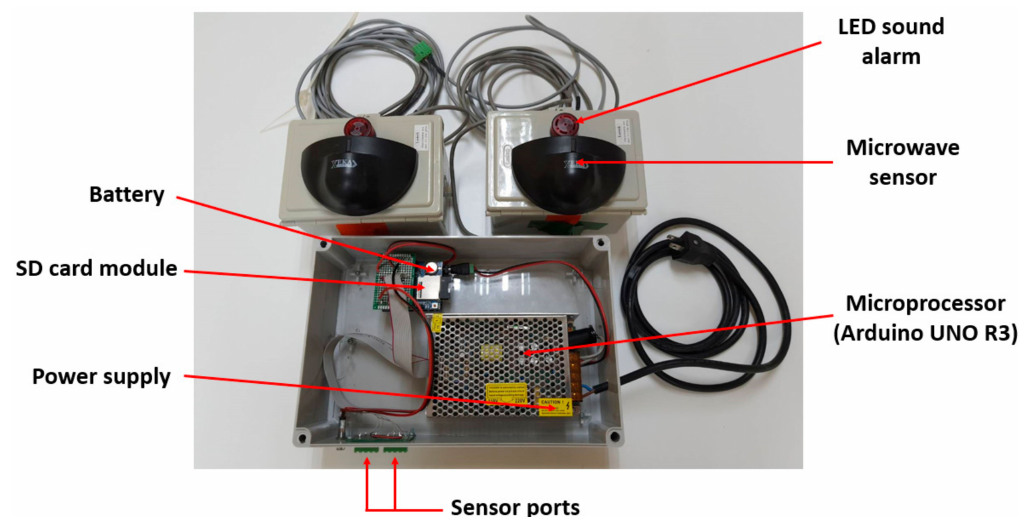
Figure 3. Layout of the AmI system